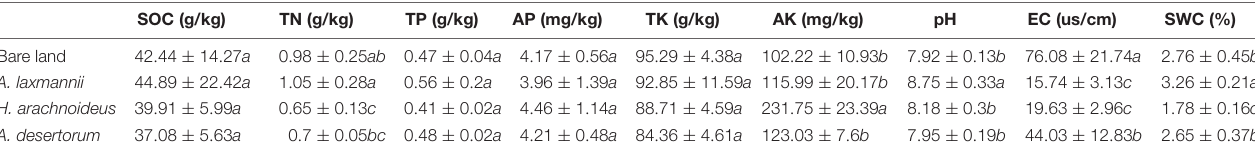
TABLE 2 | Soil physiochemical properties among bare land and different re-vegetated plant species.